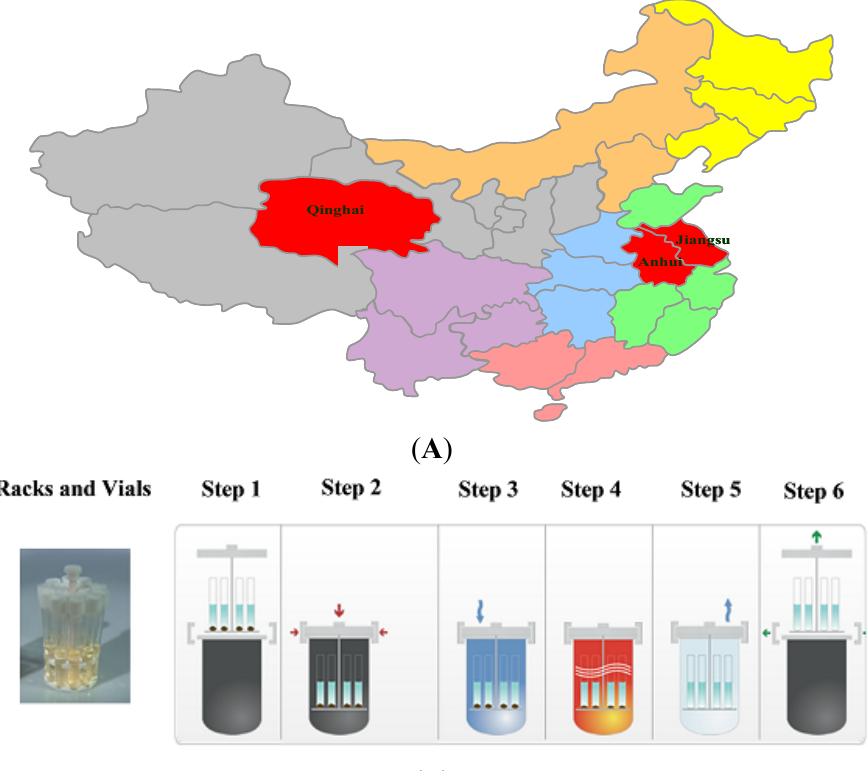
Figure 1. Origins of the samples and the ultrawave digestion procedure. ( A ) The distribution of the 18 batches of SO in China; ( B ) The ultrawave digestion